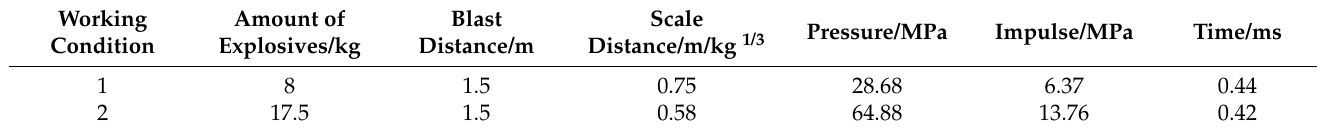
Figure 4. The sectional size of UHPC column and reinforcement. Table 2. Different explosion conditions.